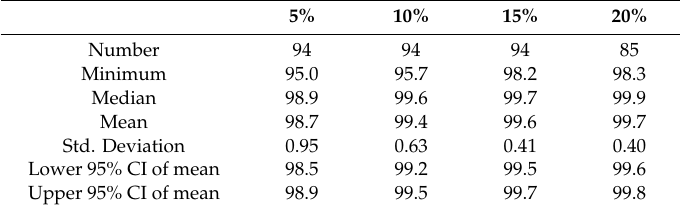
Table A2. Nucleotide sequence identity vs. VQA Sanger consensus at di ff erent variant thresholds.